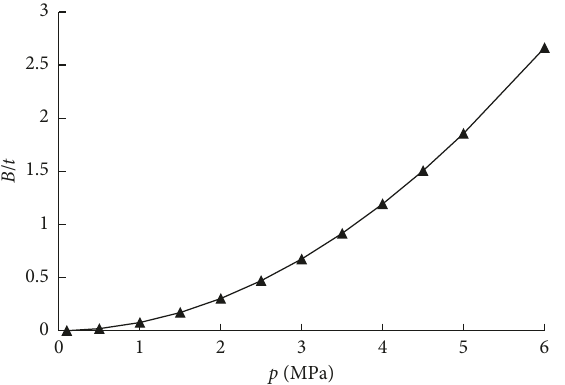
Figure 2: Relation between the gas pressure ( P ) and the mass of outburst coal ( B